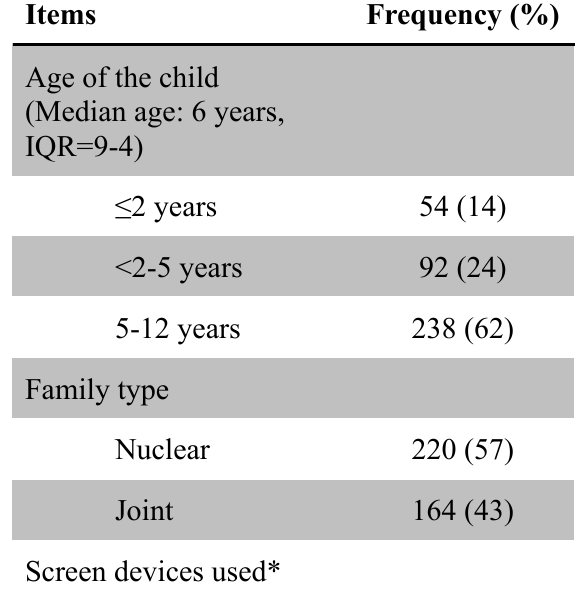
Table 3: Information related to the child and family (n=384)